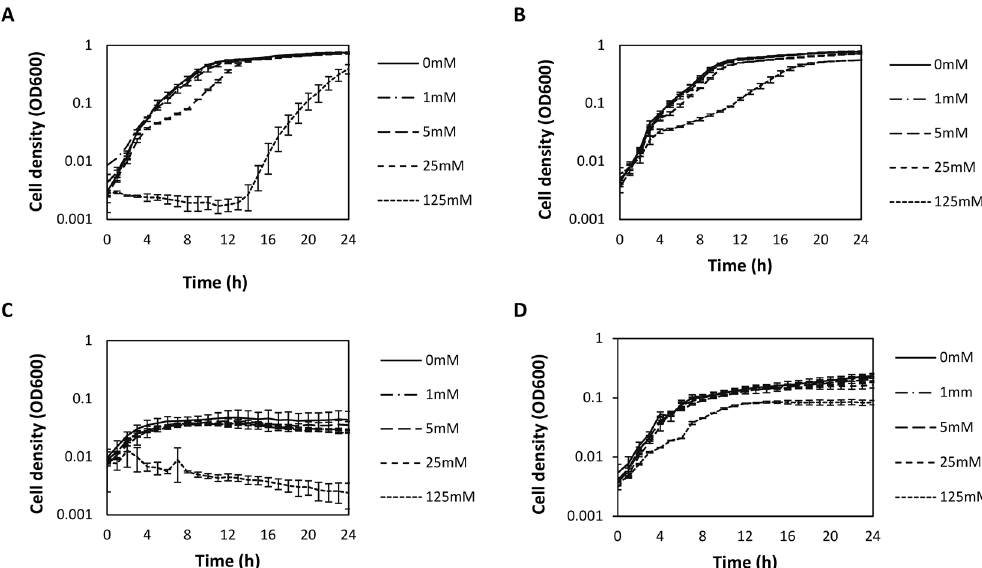
Figure 1. Growth of Vibrio campbellii ATCC BAA-1116 in nutrient-rich (panels A and B) and nutrient- poor (panels C and D) media at pH 6 (panels A and C) or pH 7 (panels B and D) in the presence of different concentrations of 3-hydroxybutyrate. The error bars represent the standard deviation of three